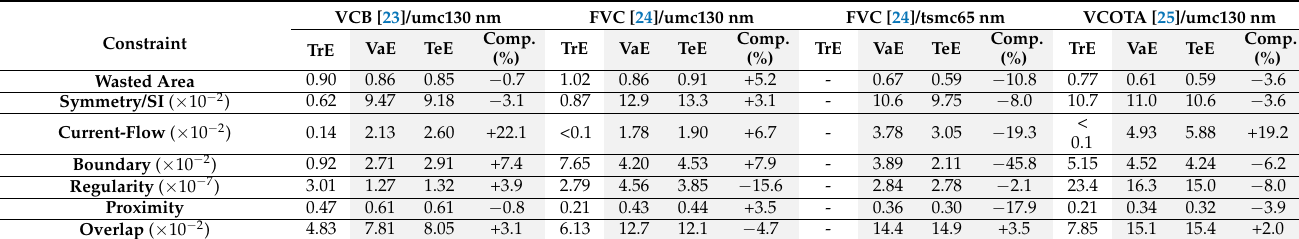
Table 4. Train (TrE), validation (VaE), and test (TeE) errors.